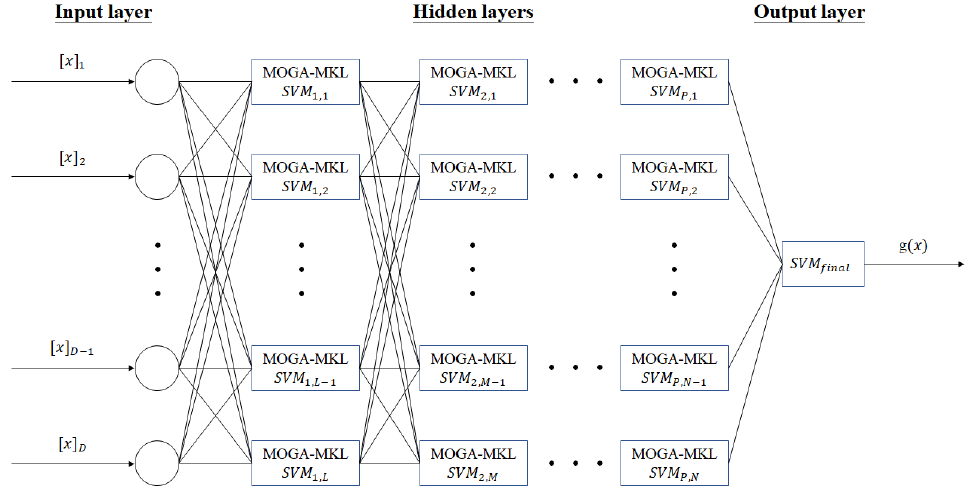
Figure 3. Architecture of MOGA optimized D-MKL-SVM.